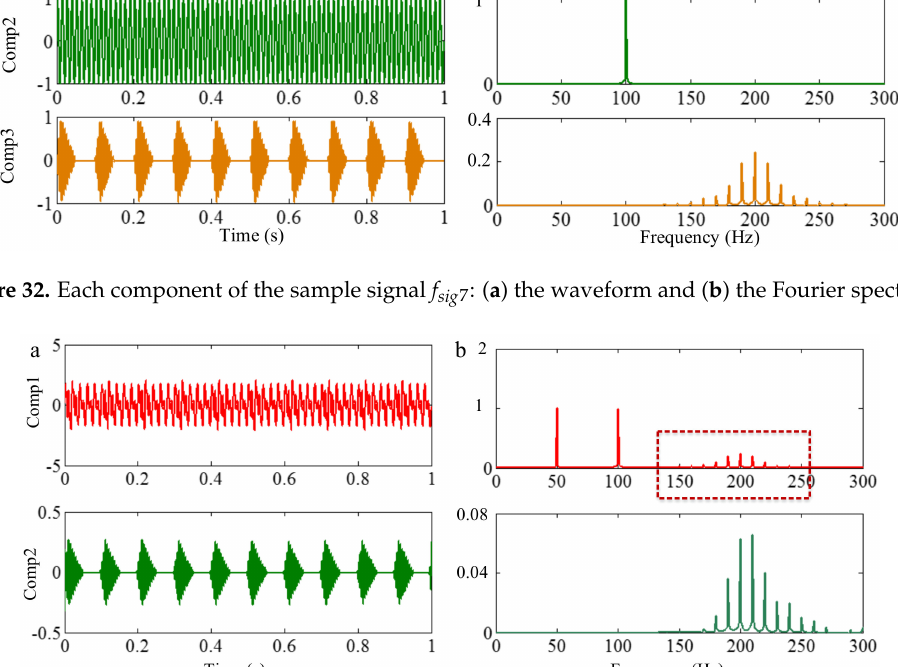
Figure 33. The waveforms of EWT result of f sig 6 and the corresponding Fourier spectrums: ( a ) waveforms and ( b ) Fourier spectrums. The parameters used in processed code are as follows: params.detect is set as ‘adaptivereg’, params.typeDetect is set as